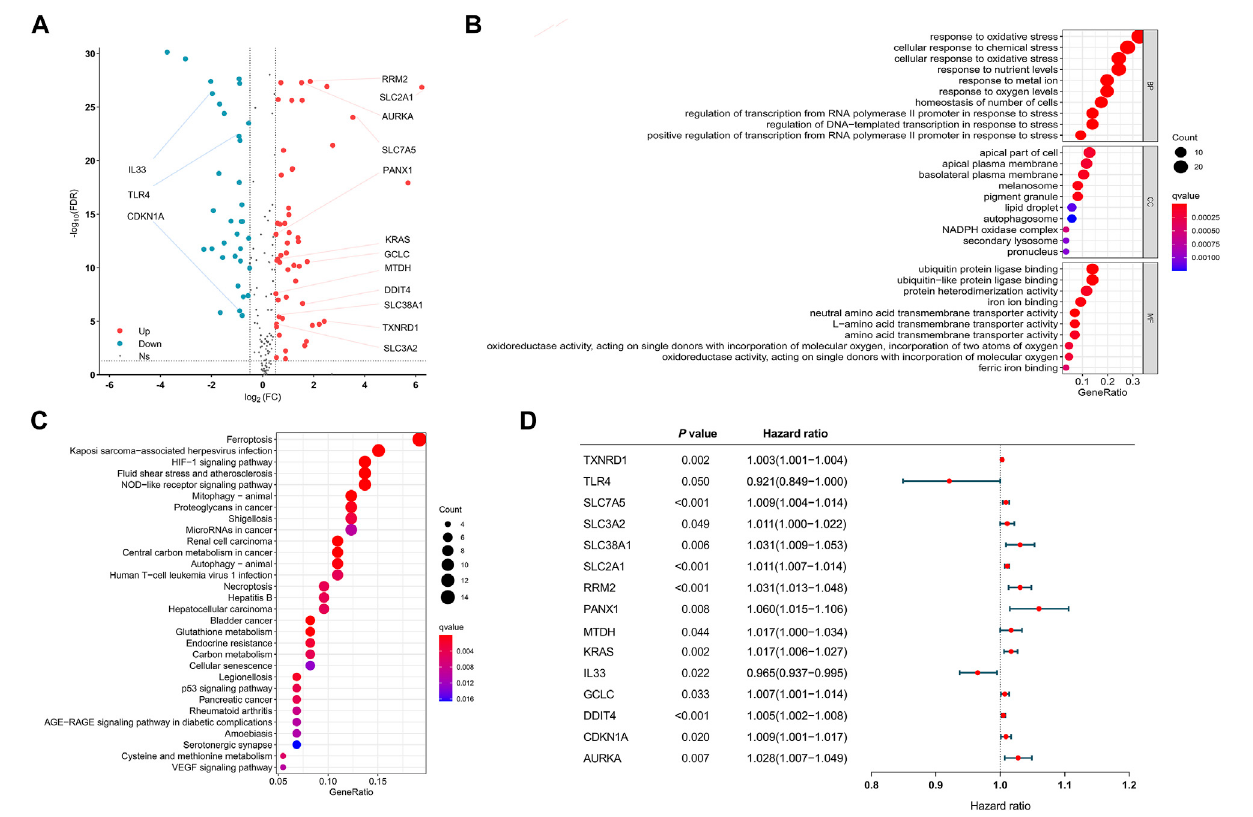
FIGURE1| Visualizationofdifferentialferroptosis-relatedgenes. (A) VolcanomapshowingFRGsbetweennormalandtumortissues. (B) GOresultsofdifferentially expressed FRGs. (C) KEGG results of differentially expressed FRGs. (D) Forest plots showing the results of the univariate Cox regression analysis between DFRG expression and overall survival. GO: gene ontology. KEGG: Kyoto Encyclopedia of Genes and Genomes. FRGs: ferroptosis-related genes. DFRGs: differentially expressed ferroptosis-related genes.